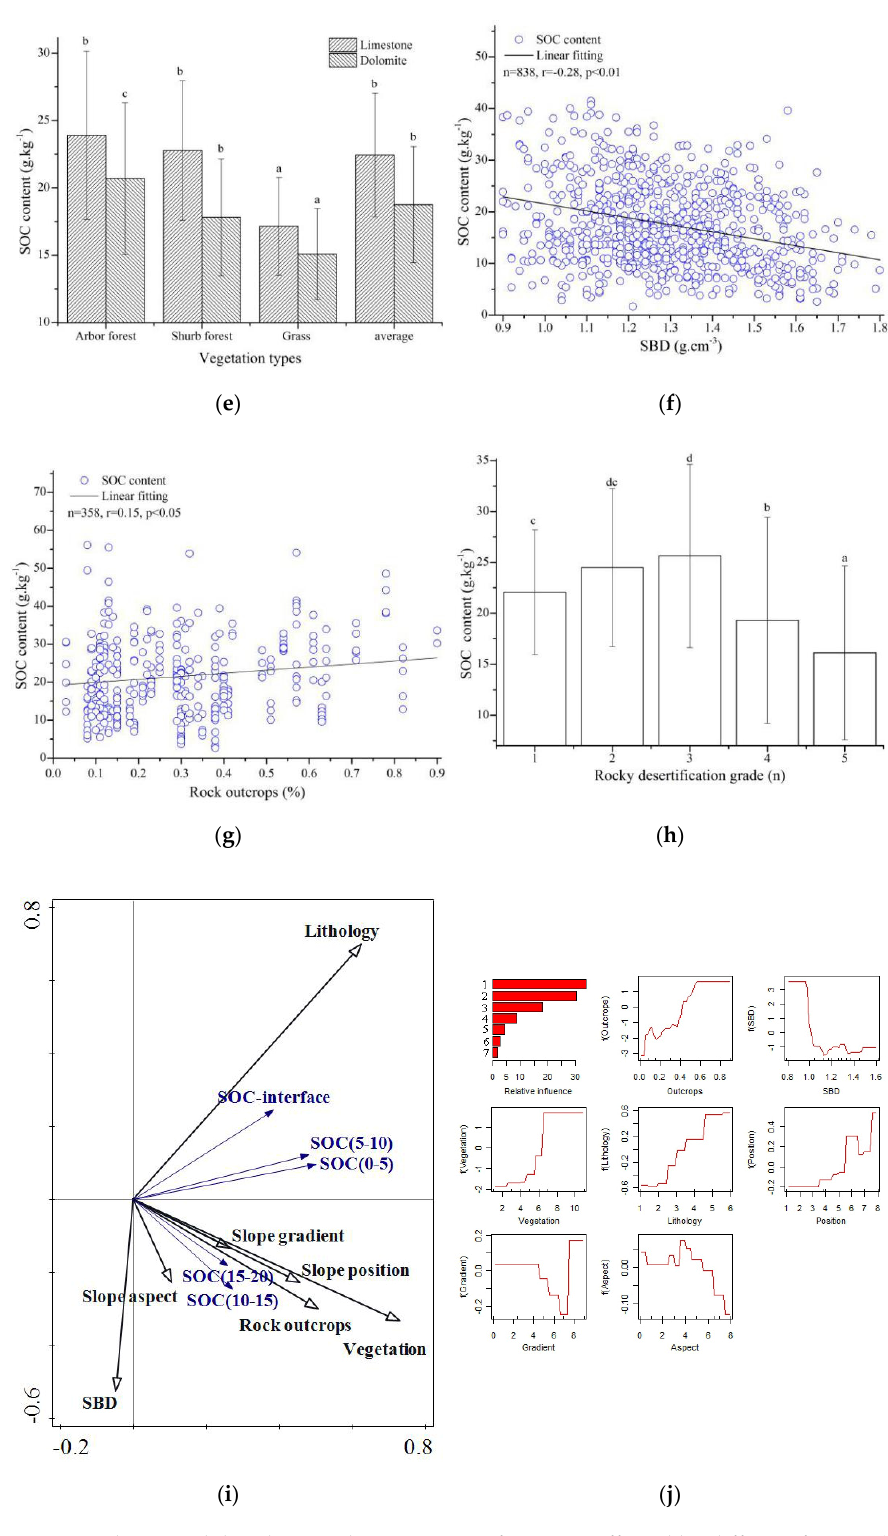
Figure 4. The spatial distribution characteristics of SOC are affected by different factors: ( a – h ) show the relationship between SOC content and slope position, gradient, aspect, vegetation, lithology, SBD, rock outcrops and changes in rocky desertification, respectively; ( i ) shows the RDA of the SOC content in the main soil layer and different impact factors; ( j ) shows the sorting of different factors affecting the SOC content by